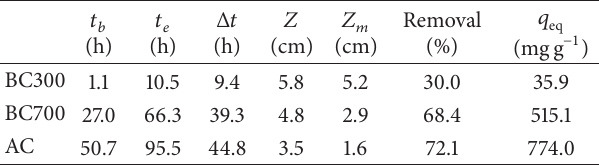
Table 2: Sorption process parameters for trichloroethylene (TCE)